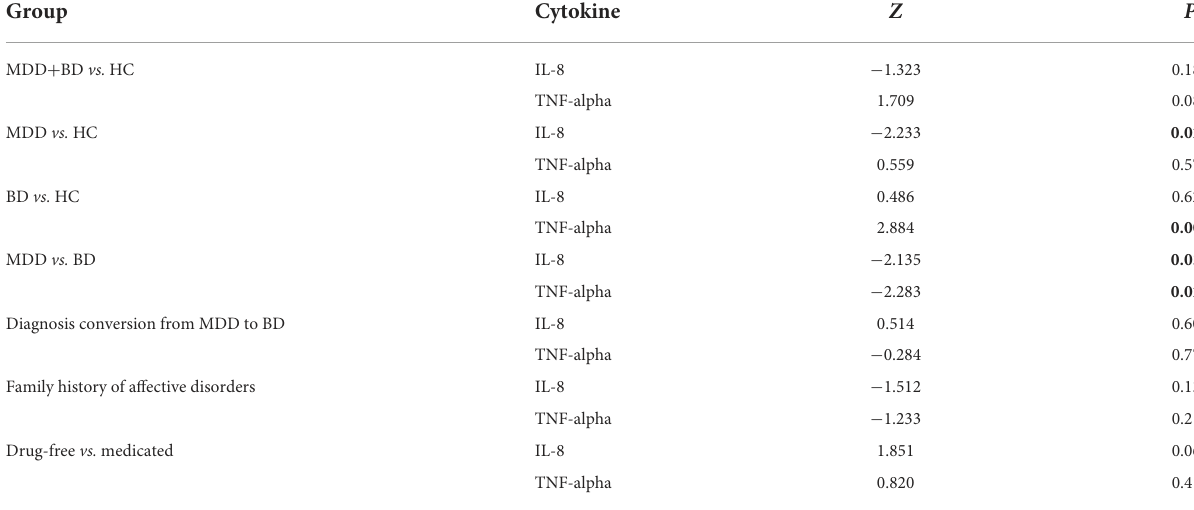
TABLE 2 Baseline comparisons of interleukin 8 (IL-8) and tumor necrosis factor alpha (TNF-alpha) levels with regard to clinical factors. Group Cytokine Z P